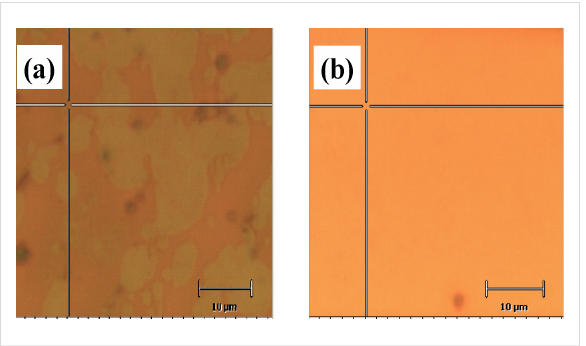
Figure 1: Optical images for (a) sample A, (b) sample B as deposited on copper